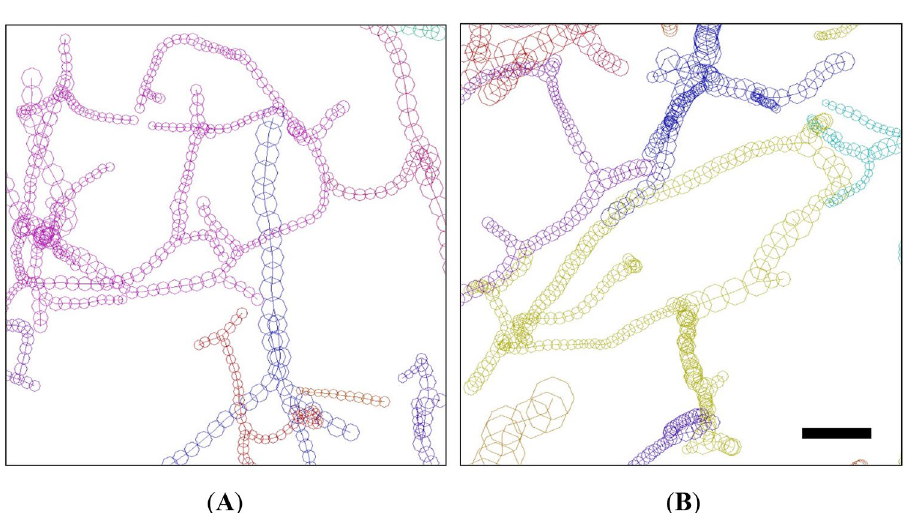
Figure 3. Vessel structures in ( A ) tissue of schizophrenia S3-22 and ( B ) tissue of control N4-22B. The capillary vessels of S3-22 had curved structures, whereas those of N4-22B were rather straight. The pial surface is toward the top. The structures are drawn to the same scale using MCTrace. Nodes composing each vessel are indicated with octagons. The color coding and structural orientation are the same as in Supplementary Figures S2 and S7. Scale bar: 50